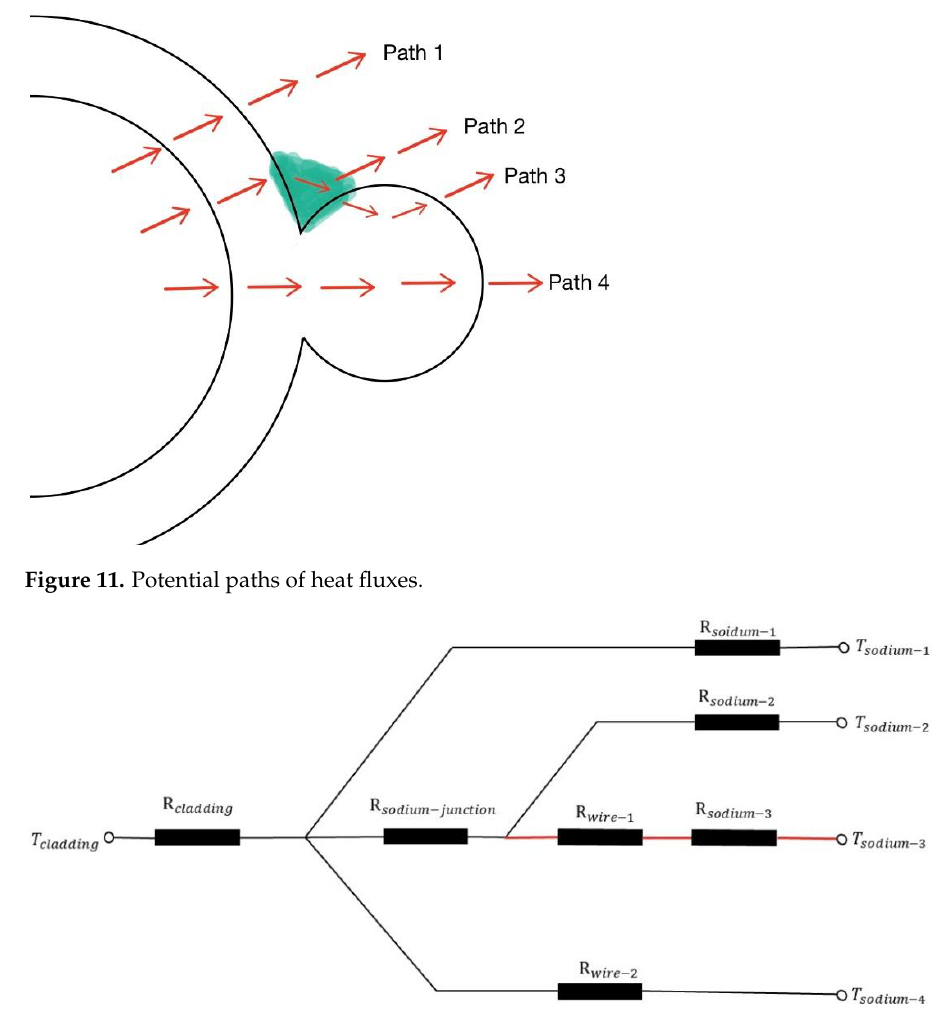
Figure 12. Thermal resistance for each path.